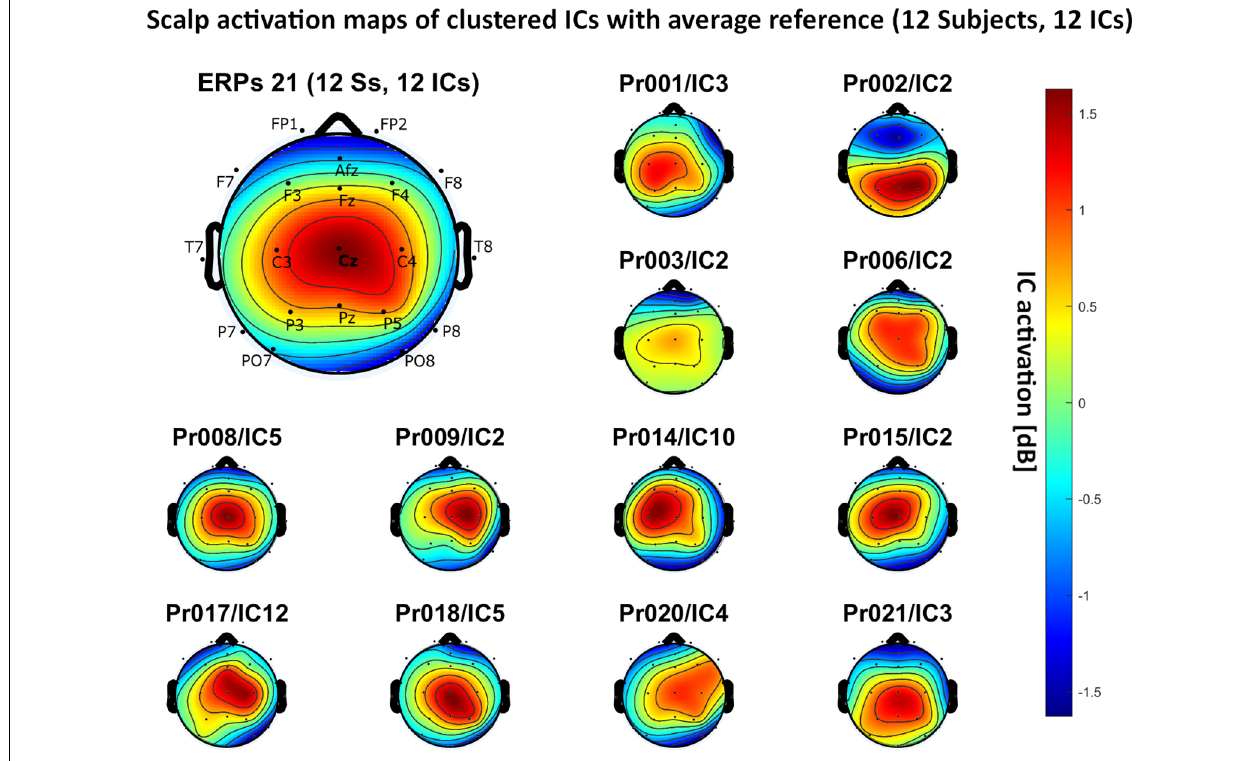
FIGURE 6 | Scalp activation for the selected ICs for 12 subjects with average reference as referencing technique. The color-coding indicates the activation of the components in dB. The average activation is plotted in the top-left corner, including detailed electrode